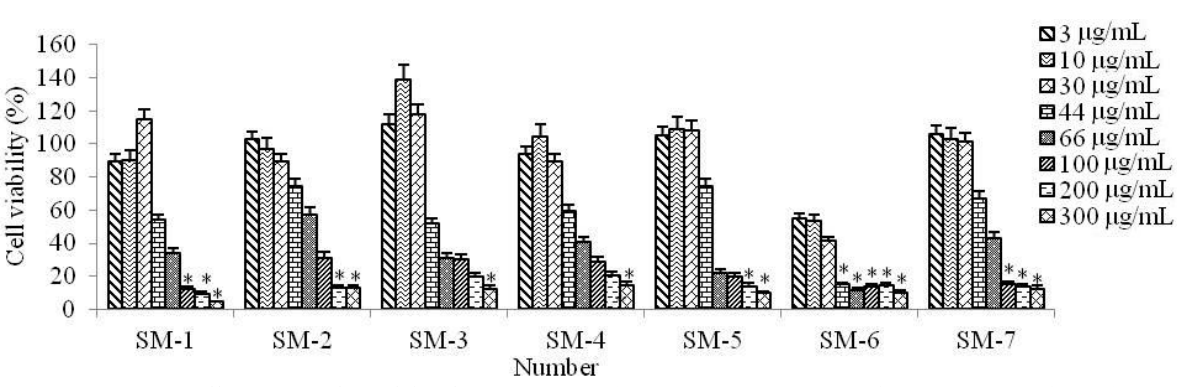
Figure 1. MTT cytotoxicity assay results for the seven Stellaria media